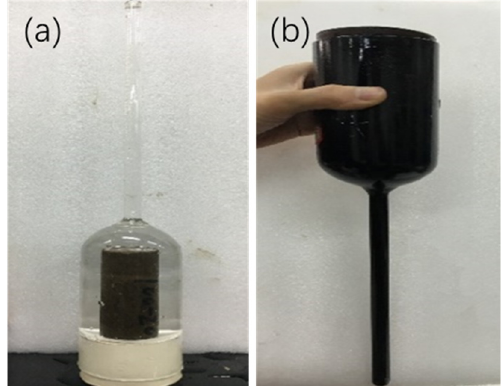
Figure 4. Meters used for measurements of: ( a ) water imbibition; ( b ) oil imbibition.